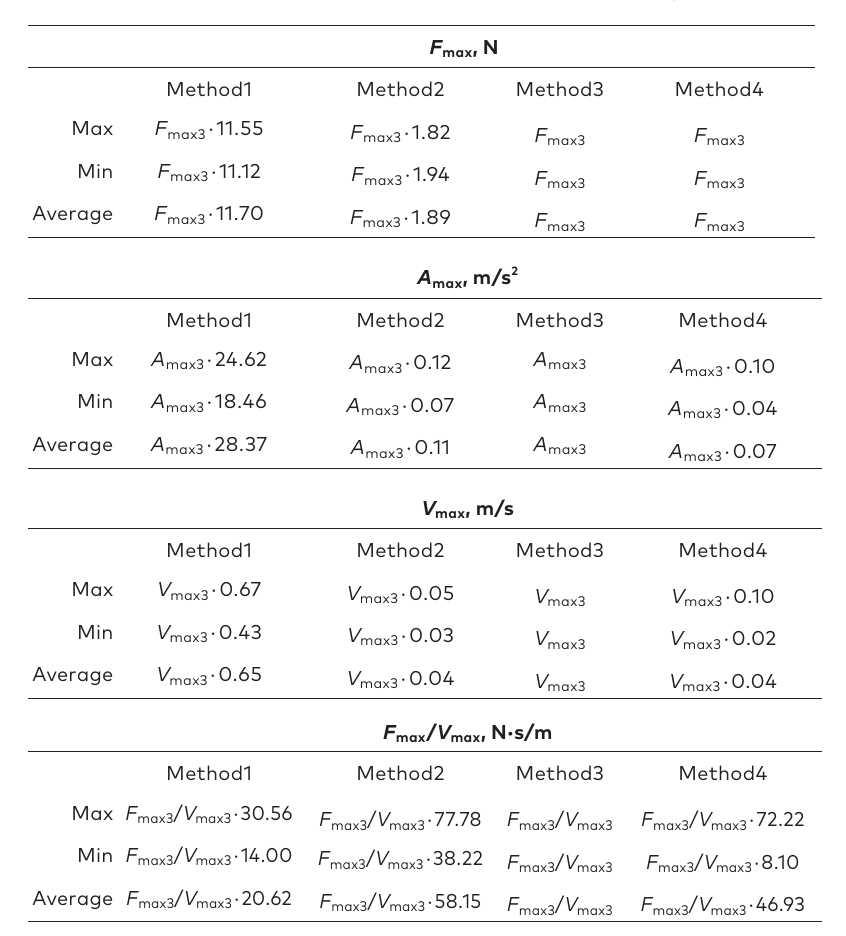
Table 9. Main statistics of signals over